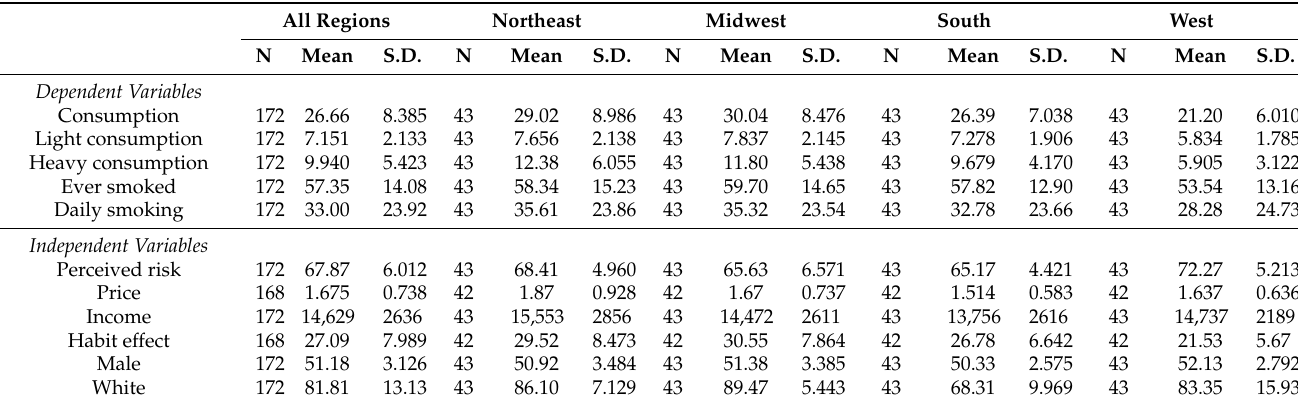
Table 1. Summary